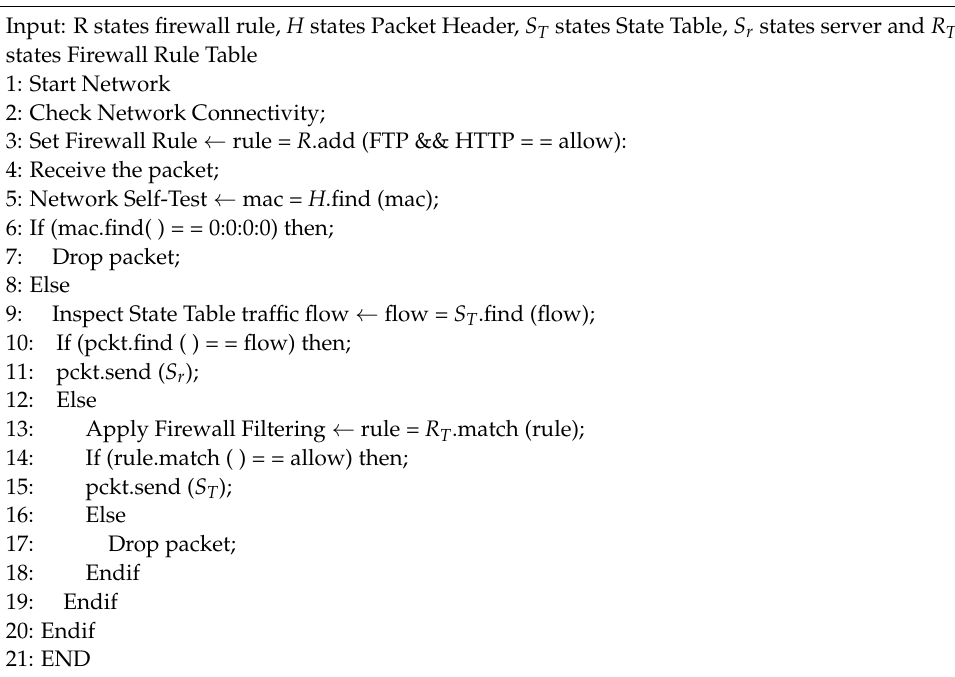
Algorithm 1: Algorithm for centralized stateful packet filtering and R T states Firewall Rule Table